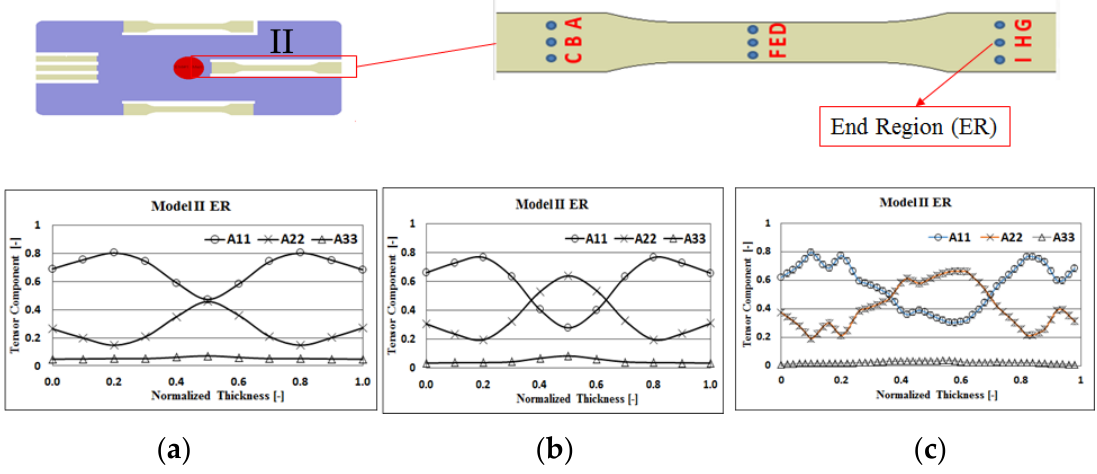
Figure 12. The comparison of the fiber orientation tensor components for Model II at Point H at ER: ( a ) simulation without flow–fiber coupling, ( b ) simulation with flow–fiber coupling, ( c ) experimental observation.